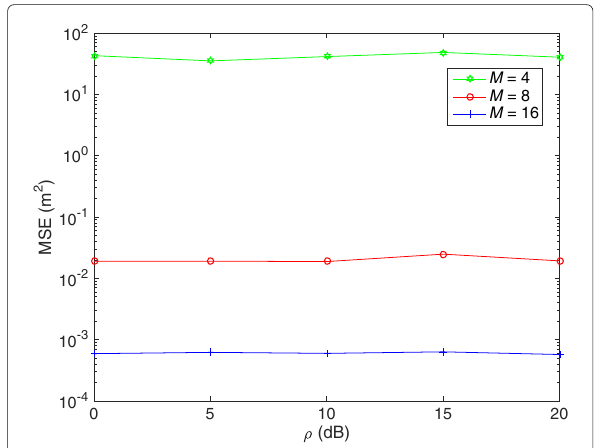
Fig. 9 Numerical result 7. MSE versus ρ with M as a parameter, for B = 80 MHz, δ = 2 ns, and N P =